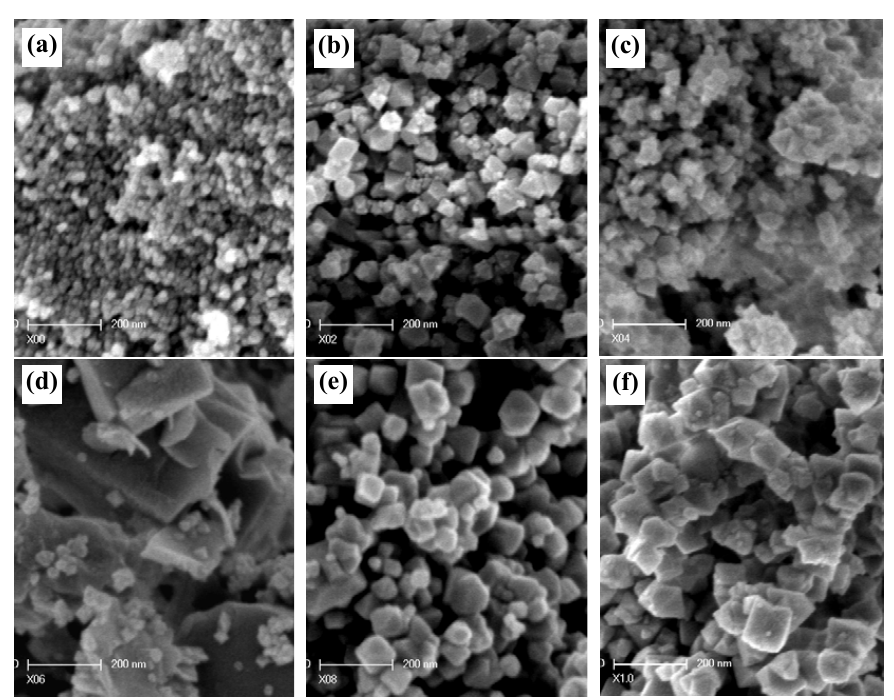
Fig. 4 SEM Micrograph of: a) CoFe 2 O 4 ; b) Ni 0 . 2 Co 0 . 8 Fe 2 O 4 ; c) Ni 0 . 4 Co 0 . 6 Fe 2 O 4 ;